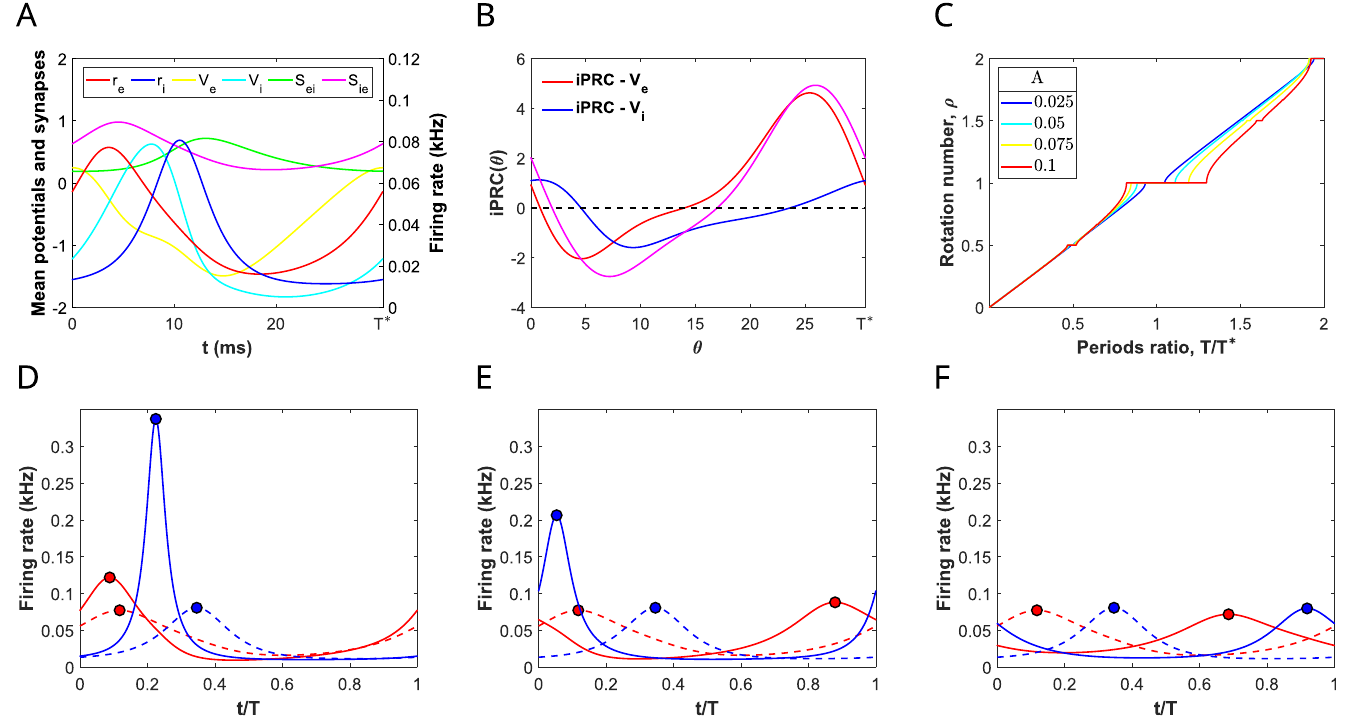
Fig 9. PING oscillations close to a Hopf bifurcation. (A) Temporal evolution of firing rate, mean membrane potential and synaptic variables over a cycle of a PING oscillation for system (1)-(2) corresponding to external current � I ext ¼ 8 : 4 (close to the Hopf bifurcation curve in Fig 2A). (B) Infinitesimal Phase Response Curve e (iPRC) of the cycle in Panel A for perturbations in the direction of the variables V e and V i (red and blue curves, respectively) and to both of them (purple curve). Note that the iPRC Z þ Z is both positive and negative. (C) Rotation numbers of the stroboscopic map (9) for a von Mises input (15) with coherence κ = 2 applied in the V e V i direction of V e and V i , as a function of the ratio between the intrinsic period of the E-I network T � and the input period T and different amplitude values A . (D, E, F) Time evolution of the mean firing rates of the E-cells (red) and I-cells (blue) along the unperturbed (dashed curves) periodic orbit for the system (1)-(2) and perturbed (solid curves) with the coherent von Mises input with A = 0.05 and relative frequency T / T � : (D) 0.9, (E) 1 and (F) 1.07. The period of the oscillators has been normalized to 1.